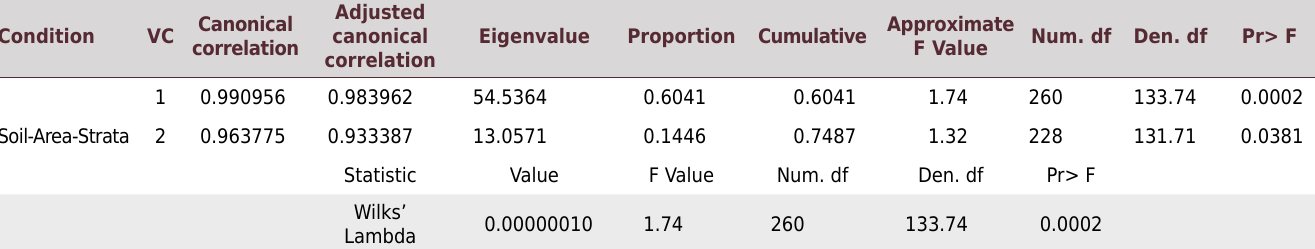
Table 5. Summary of the canonical variate analysis of the physical, chemical, and biological properties of an Alfisol and an Entisol from the preserved Caatinga (strata: catingueira, jurema, marmeleiro and between trees), the recovery area with jurema (strata: jurema and between trees), and the degraded area without plant cover Condition